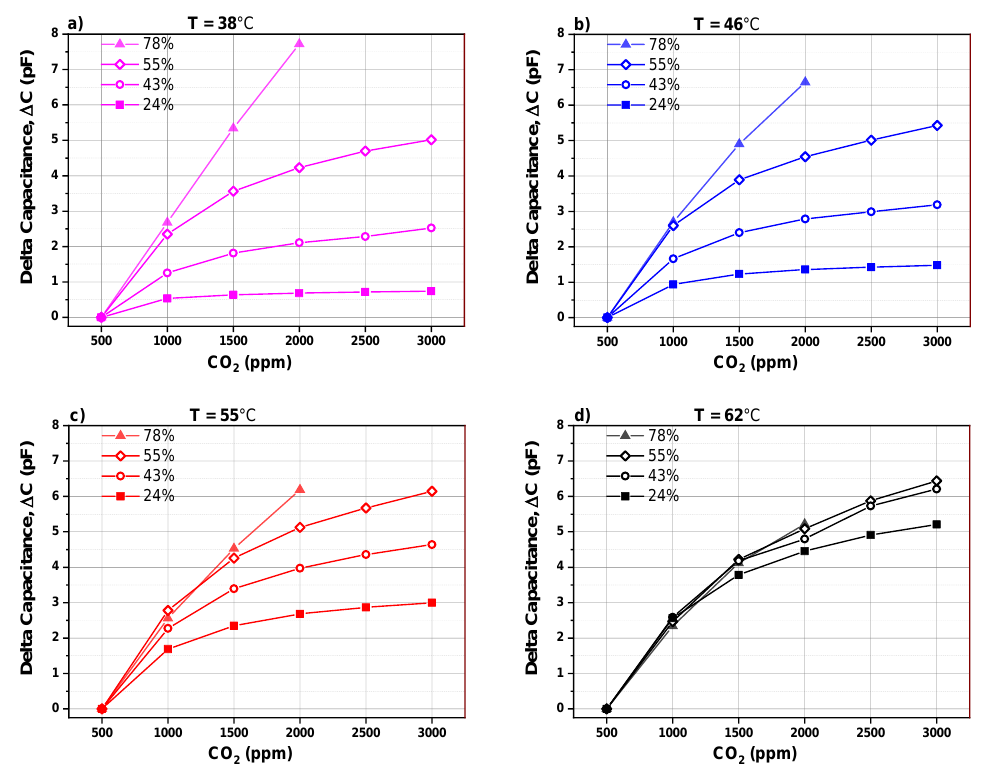
Figure 7. Capacitance change versus CO 2 concentration for different humidity levels of a PEI@silica-based CO 2 sensor at different operating temperatures: ( a ) 38 °C, ( b ) 46 °C, ( c ) 55 °C and ( d ) 62 °C.